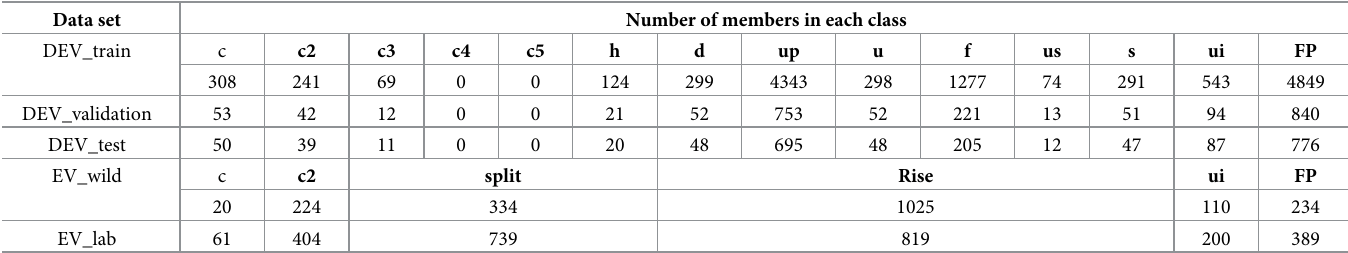
Table 1. Number of instances for each class in the different datasets.